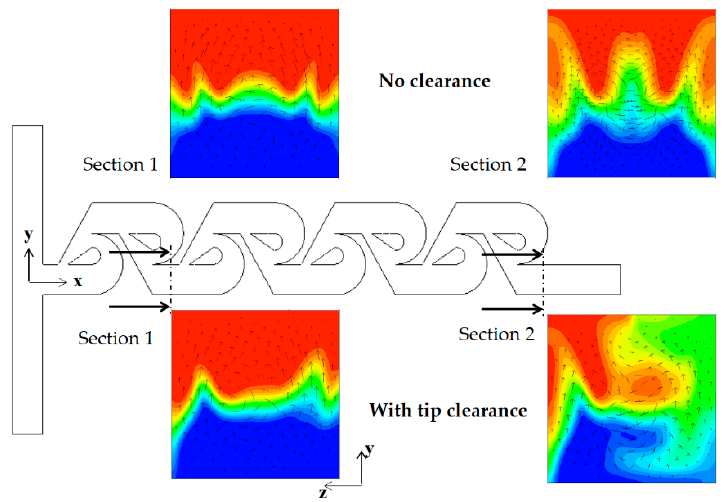
Figure 15. Concentration contours with velocity vector on the yz planes for Re = 10.